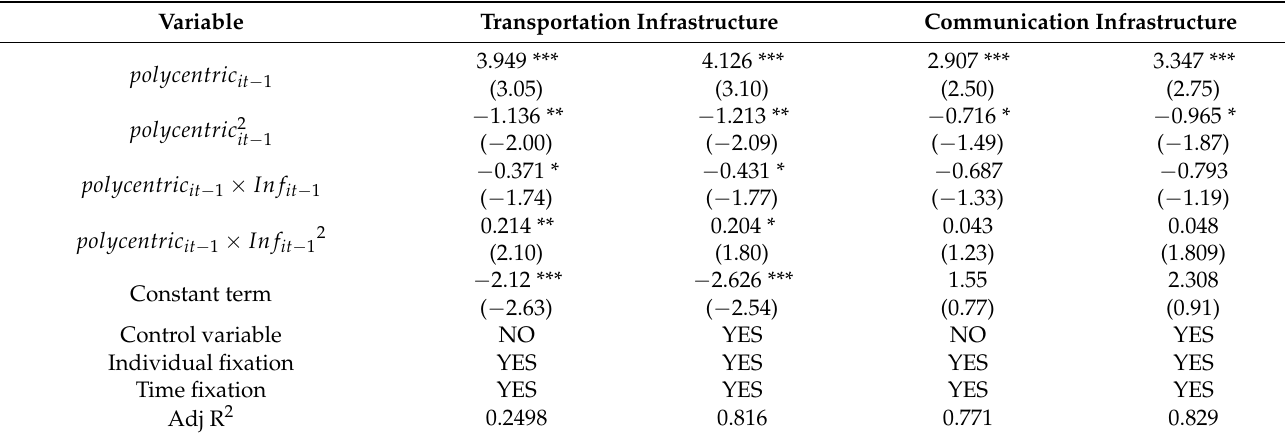
Table 8. Test the moderating effect of